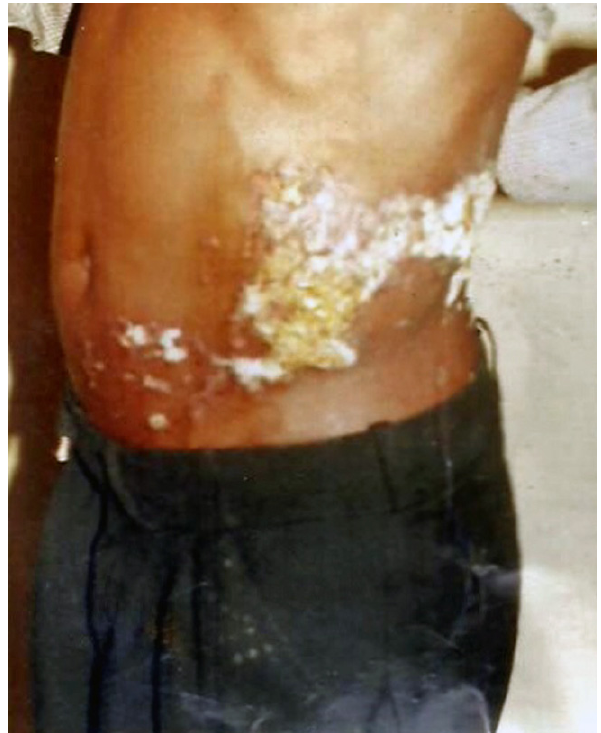
Figure 3. Skin lesion following scorpion sting